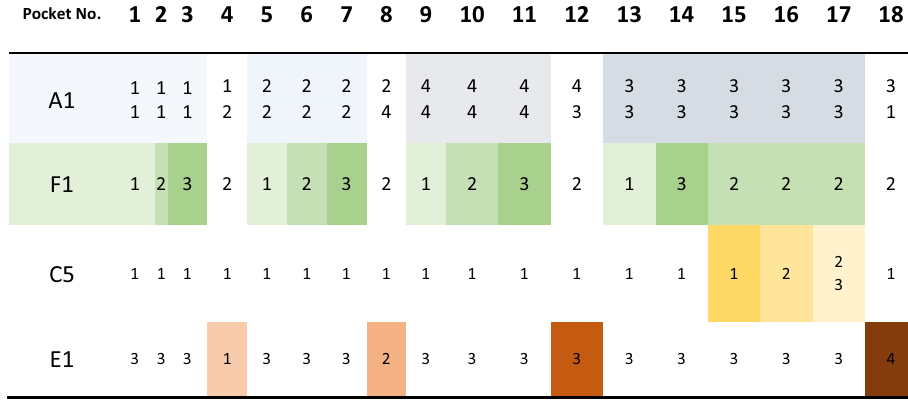
Table 1. Configuration of the 18 pockets based on the selected geometrical parameters and their variation levels. Color coded based on different parameters with darker shades denoting higher levels of each parameter.